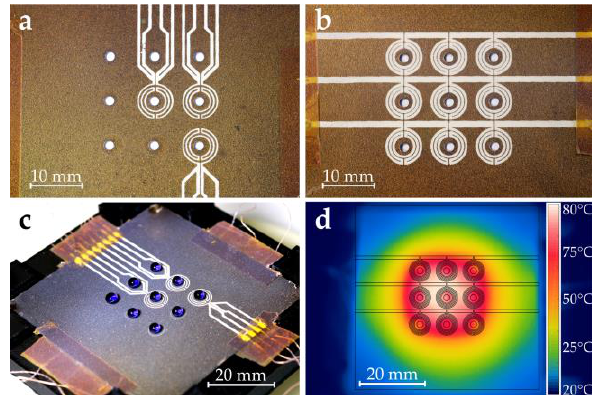
Figure 4. Fabricated dosage plate. ( a ) Close-up of RTDs. ( b ) Close-up of microheaters. ( c ) Fully loaded superhydrophobic dosage plate (droplets are DI water colored with blue ink). ( d ) Infrared camera picture of temperature distribution at 4 V. Note that the outline of the heater layout was overlaid to indicate the heater position. Part (d): © 2019 IEEE. Reprinted, with permission, from Hintermüller et al. [5].